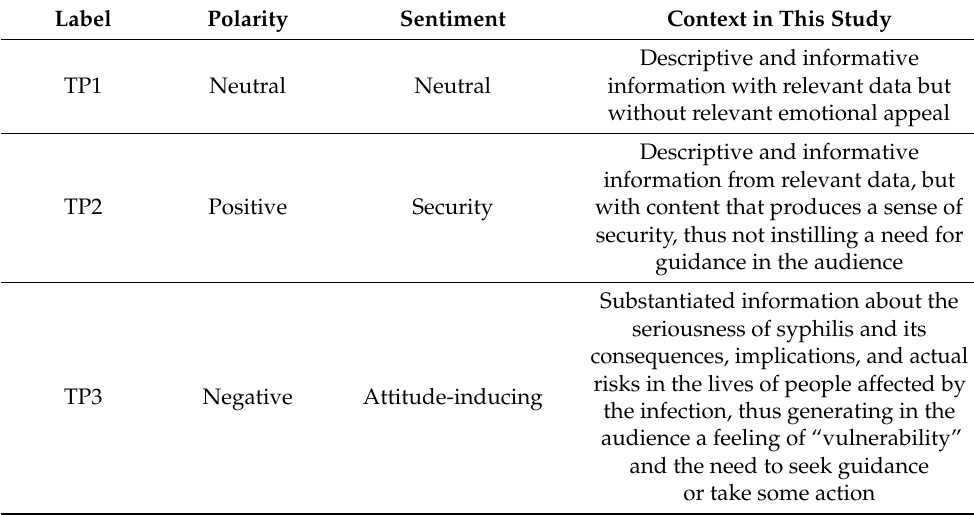
Table 1. Terminology proposed based on the content analyzed in the news, according to characteristics proposed by Ard è vol-Abreu et al.